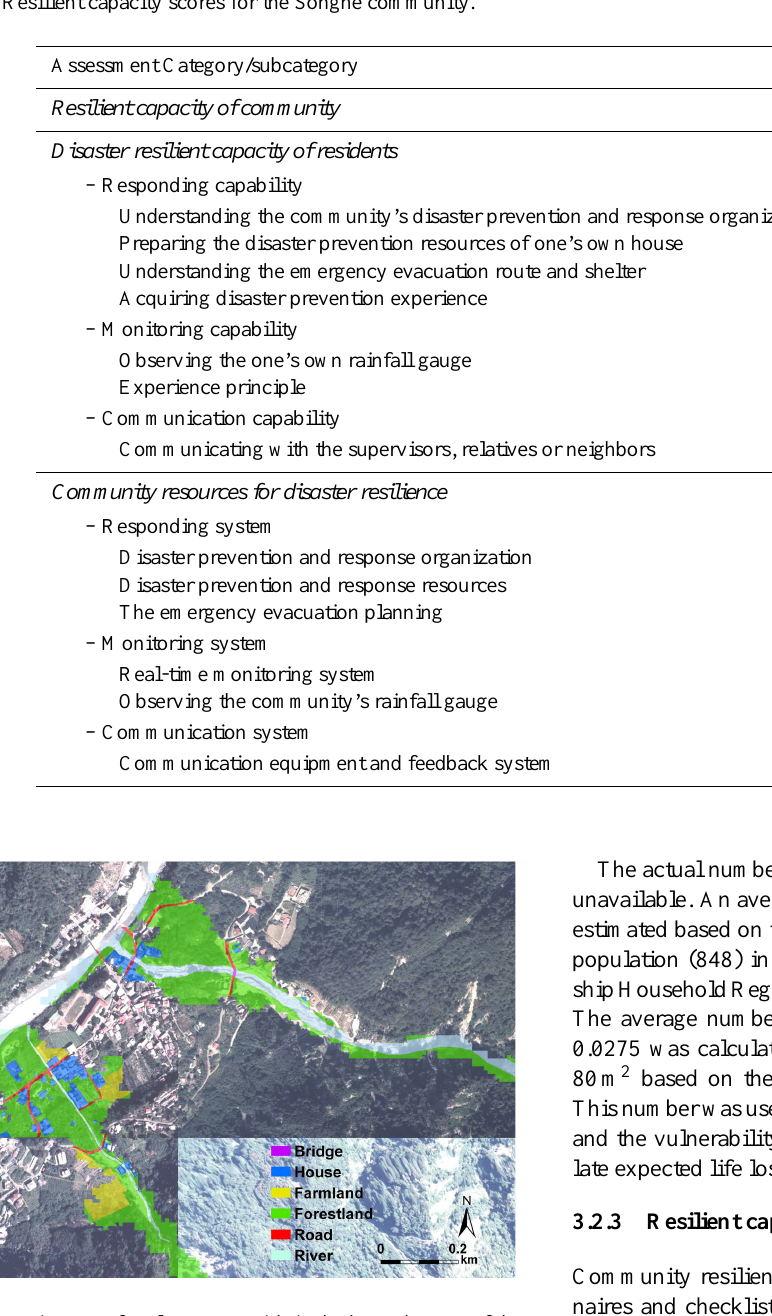
Fig. 3. Location map for elements at risk in the hazard zones of the Figure 3. Location map for elements at risk in the hazard zones of the No. 1 and No. 2 3 Nos. 1 and 2 Torrents. 4